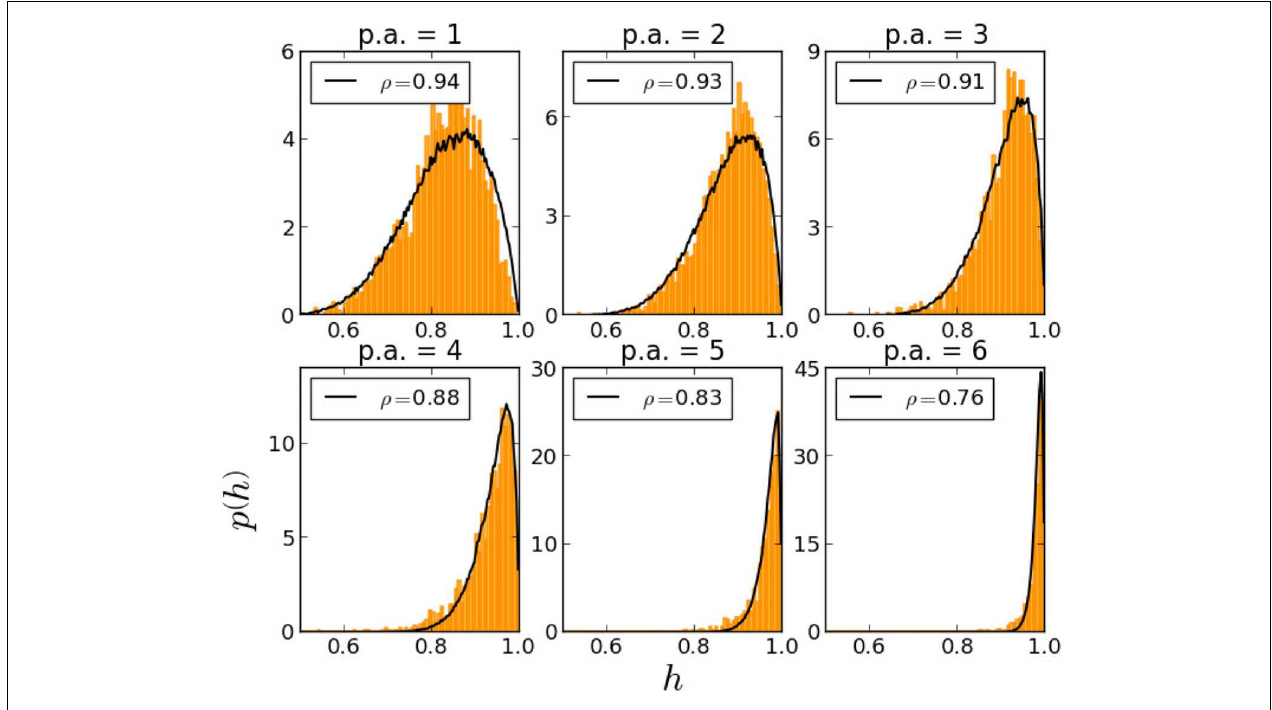
between moral weights of a the agents and a given Zeitgeist direction ( ZZ (1 , 1 , 1 , 1 , 1) in the simulation) are represented by the black line. = In each graph we find ρ that best fits the empirical histogram for pressure β 3 . 8 and for each political affiliation group. Simulations are = performed on a Barabási-Albert network with N 400 and average = degree 20